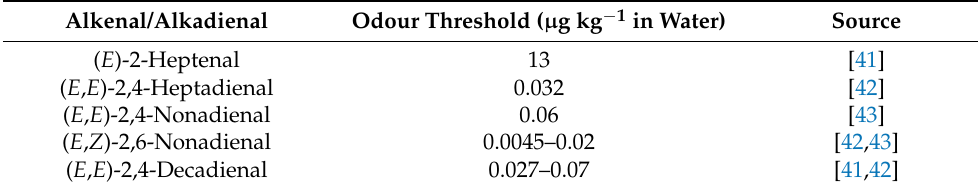
Table 2. Odour thresholds of selected alkenals and